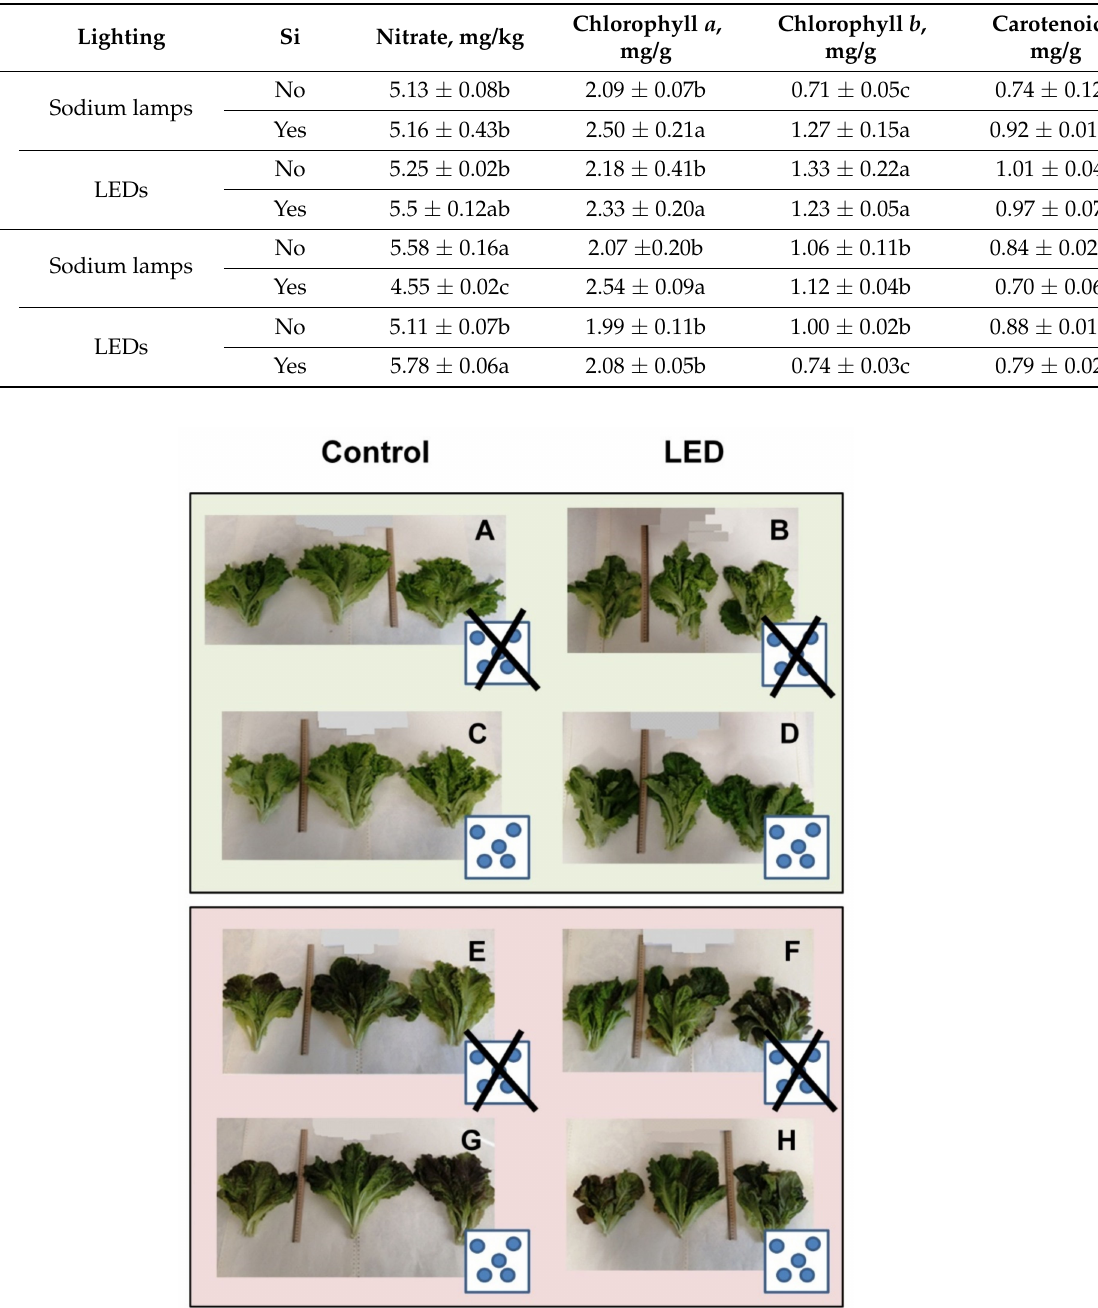
Table 6. Average concentrations of chlorophyll a and b , carotenoids, and nitrates in green and red lettuce ( Lactuca sativa L.) under conditions of a regulated agroecosystem on the 45th day of cultivation. Values represent mean ± SE ( n = 12). The different letters indicate significant differences among treatments means non-significant differences among treatments according to Duncan’s test ( p ≤ 0.05).